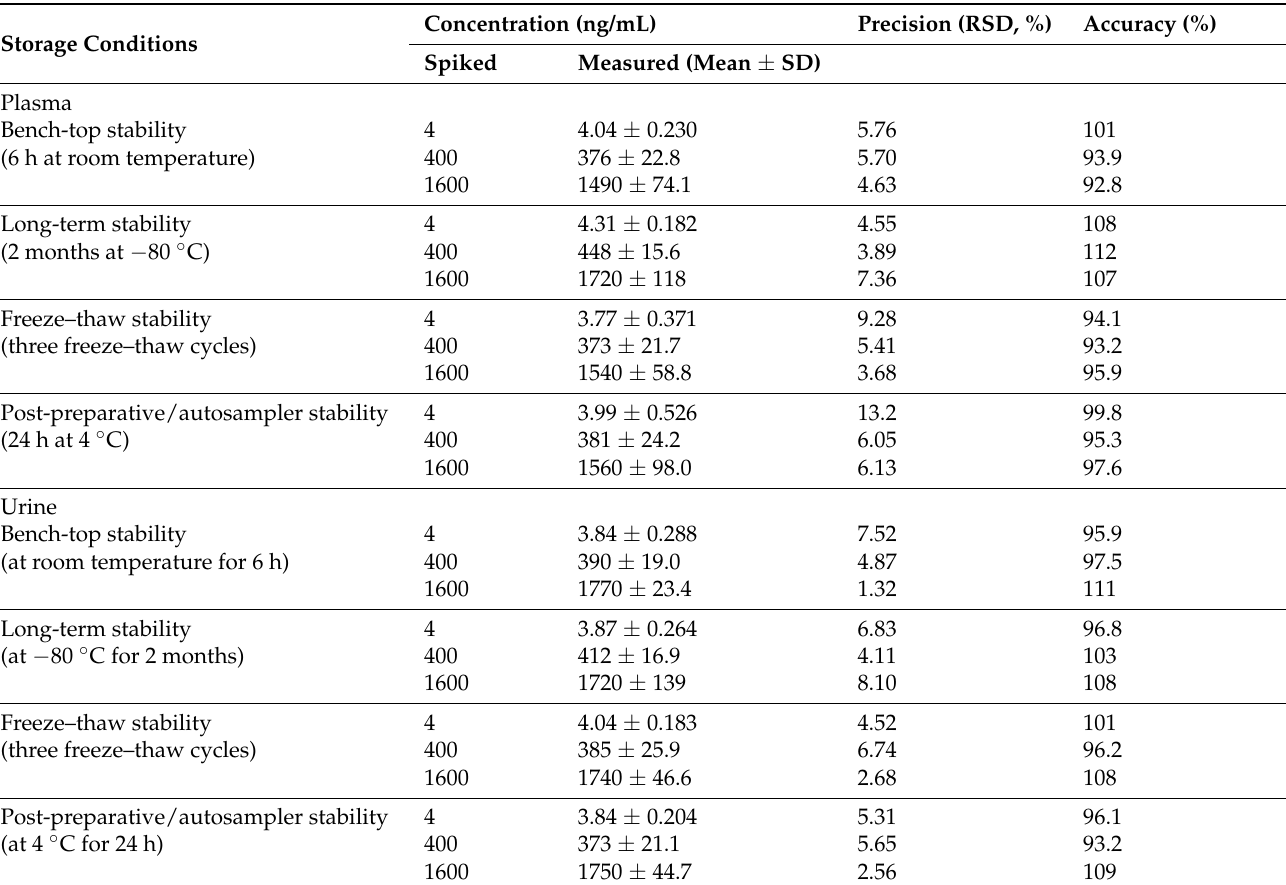
Table 3. Stability of BIT in rat plasma and urine under various conditions ( n =